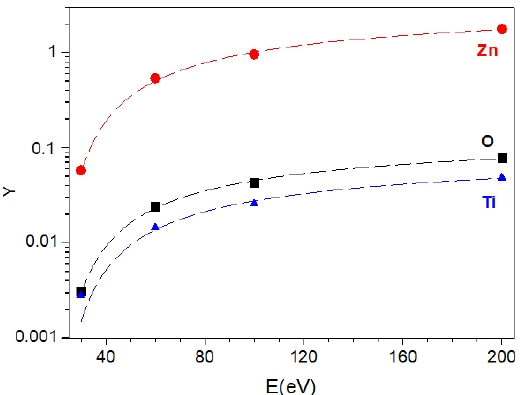
Figure B1. Simulated sputtering yield for Zn, O and Ti from a TZO film with 5 at.% Ti for a wide range of Ar ion energies. The simulated values (dots) are satisfactorily fitted to a Bohdansky behaviour (dashed line).